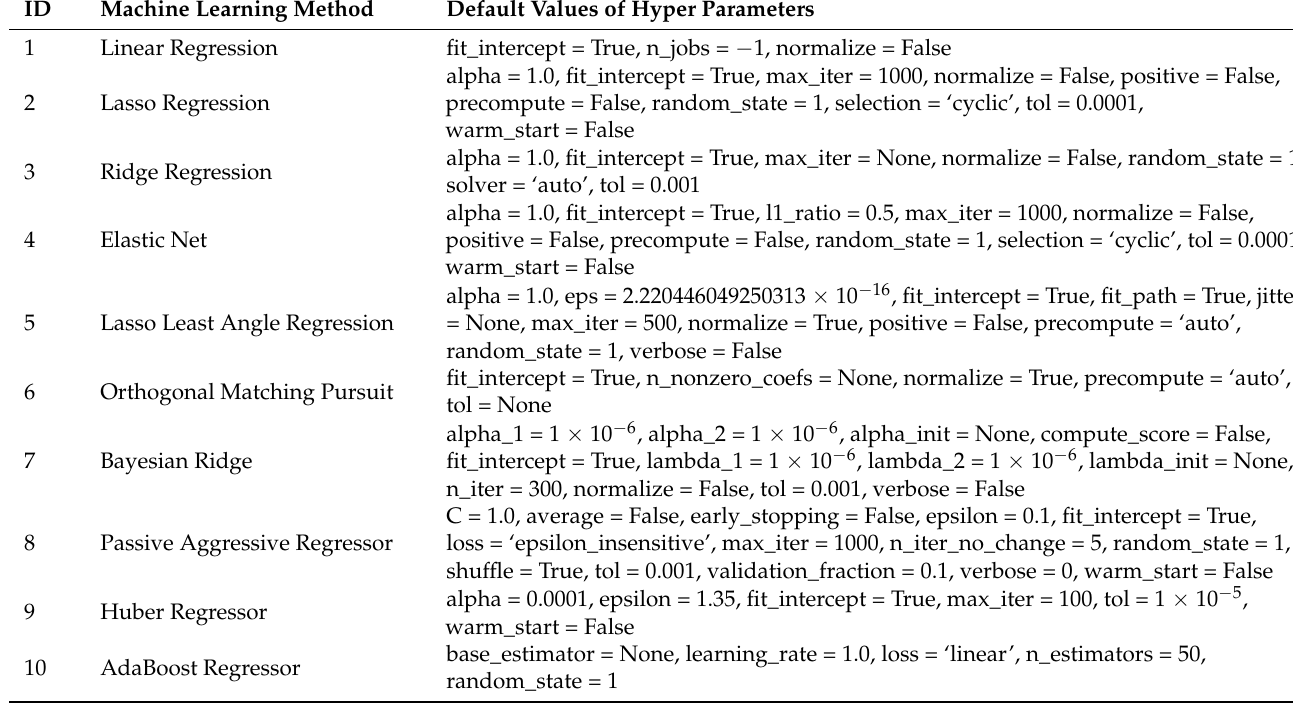
Table A1. Default Values of Hyper Parameters Used for the AutoML method (PyCaret version 2.3.10) [16].